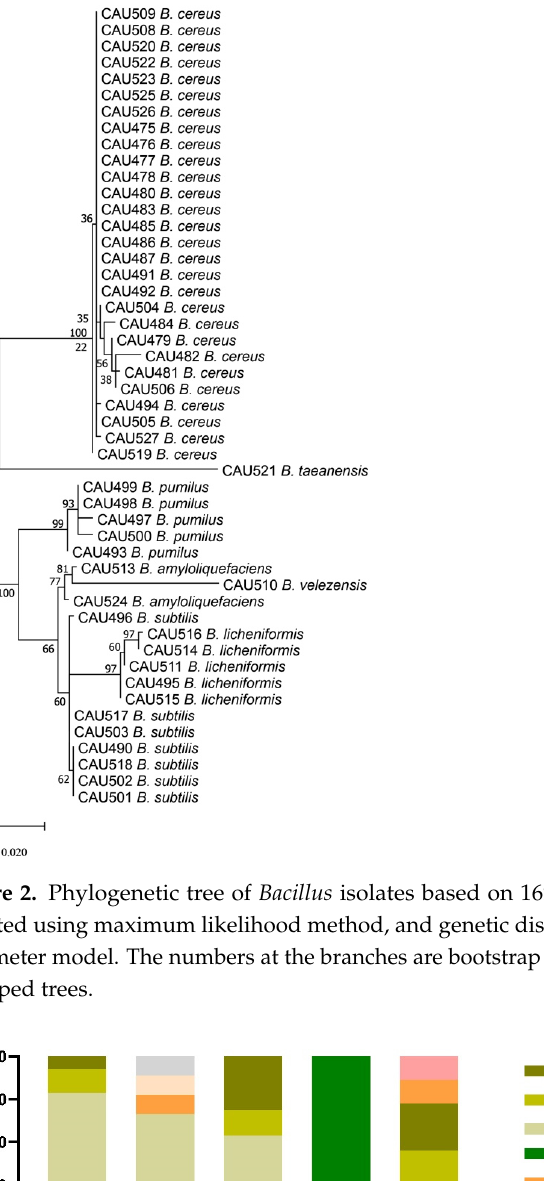
lus isolates showed complete resistance to florfenicol and lincomycin. The resistance rates towards ampicillin, amoxicillin + clavulanate and ceftriaxone were 67.3%, 54.5% and 70.9%, respectively (Figure 4). A large proportion of isolates exhibited resistance to strep- tomycin and tiamulin with levels of 56.4% and 78.2%. None of the isolates showed toler- ance to either rifampin or vancomycin. It is noteworthy that all 29 B. cereus strains were resistant to ampicillin and ceftriaxone, while other Bacillus spp. were mostly sensitive to these two antibiotics (Table 2). B. pumilus isolates were susceptible to 12 antibiotics except for ceftriaxone, florfenicol, lincomycin and tiamulin. Compared with other Bacillus spe- cies, B. cereus showed more severe resistance to antibacterial agents. In terms of different food sources, Bacillus isolated from dairy products and rice products are highly resistant to penicillin–ampicillin and amoxicillin + clavulanate, for which isolates from vegetables, meat and probiotics displayed more sensitivity. Bacillus from probiotics expressed very low resistance to ampicillin, streptomycin, kanamycin, erythromycin, florfenicol, line- zolid and lincomycin. Collectively, the presence of resistant strains revealed that antimi- crobial resistance may have widely disseminated through Bacillus spp. in the food chain.